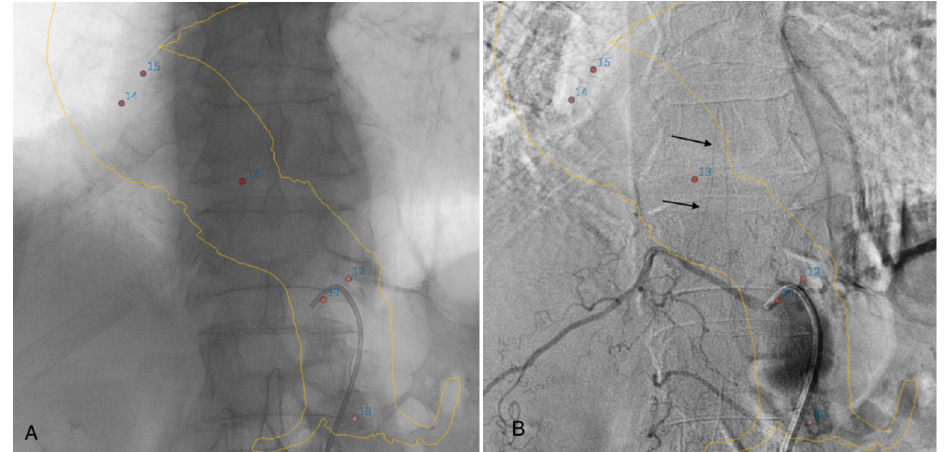
Figure 3. Three-dimensional road-mapping of the intercostal and lumbar artery ostia (red dots) and aortic wall mask (yellow lines), extracted from angio-CBCT acquisition ( A ). Selective angiography of a patent intercostal artery with visualization of the classic hairpin turns (black arrows) ( B ).